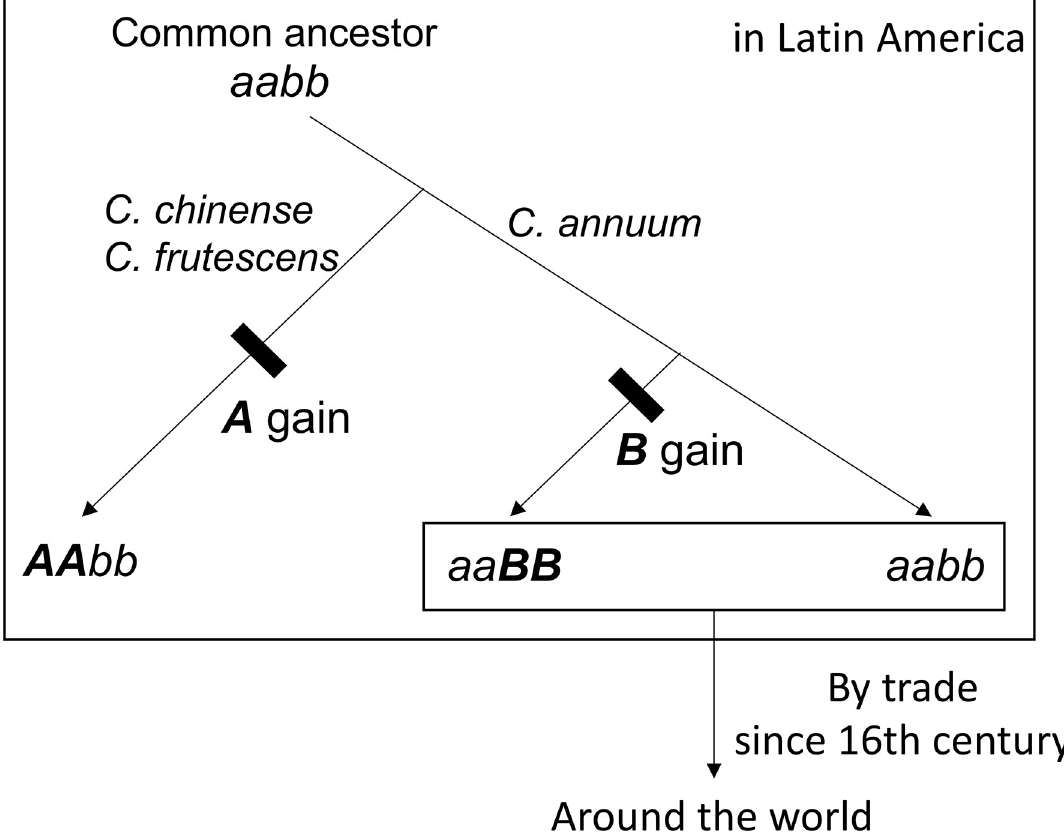
Fig 7. Model on the process of causal gene acquisition and the spread of the lines of B- or b- carriers to the world.